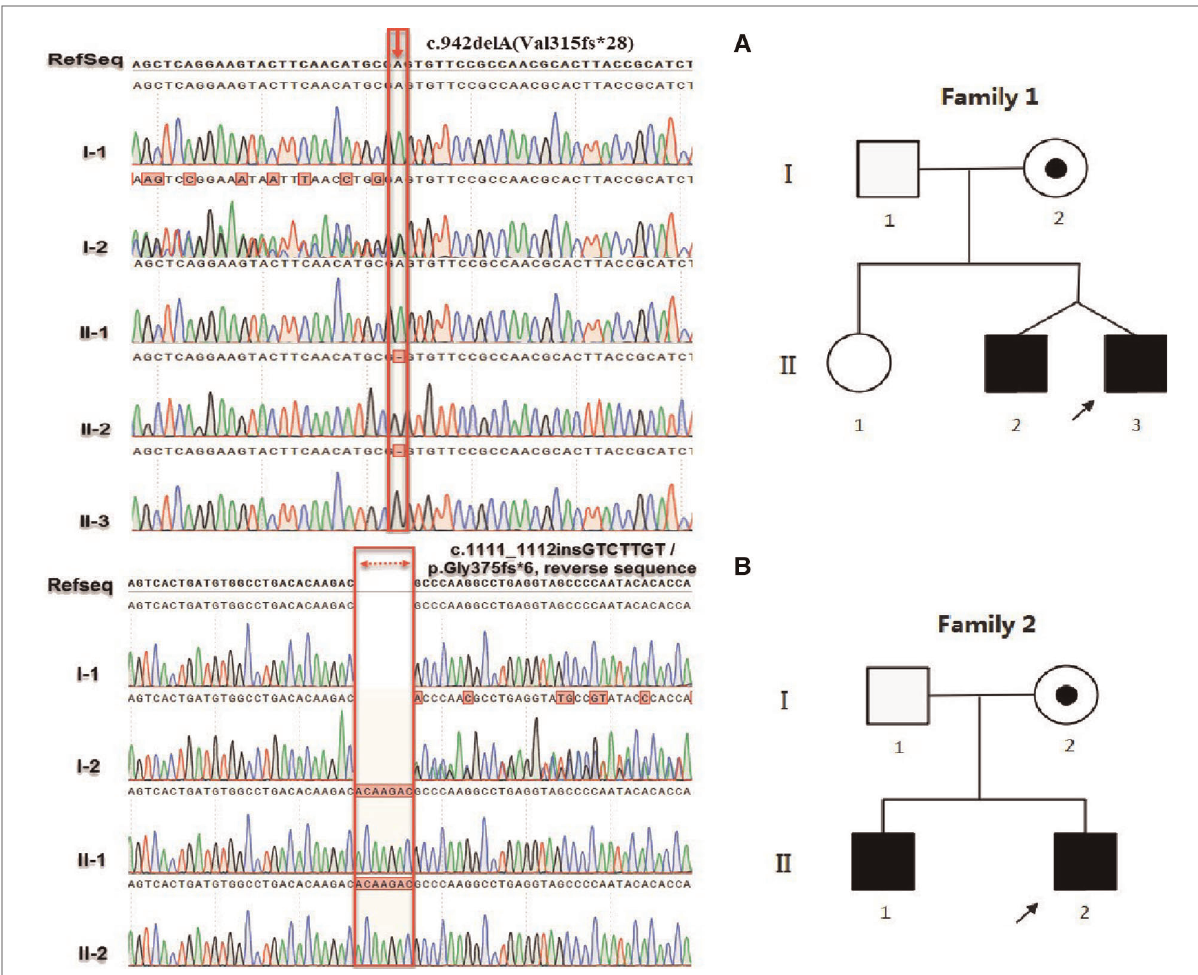
FIGURE 2 ( A ) represents the sequencing results of c.942delA(Val315fs*28) and ( B ) is the sequencing results of c.1111_1112insGTCTTGT (Gly375fs*6). In family 1, I-1, I-2, II-1, II-2 and II-3 represent the father, mother, elder sister, elder brother and the proband, respectively. In family 2, I-1, I-2, II-1 and II-2 represent the father, mother, elder brother and the proband, respectively. In the pedigree, the fi lled and open symbols represent the affected and unaffected individuals, respectively; A dot inside a circle represents the carriers; The squares and circles represent the males and females, respectively; The arrows indicate the